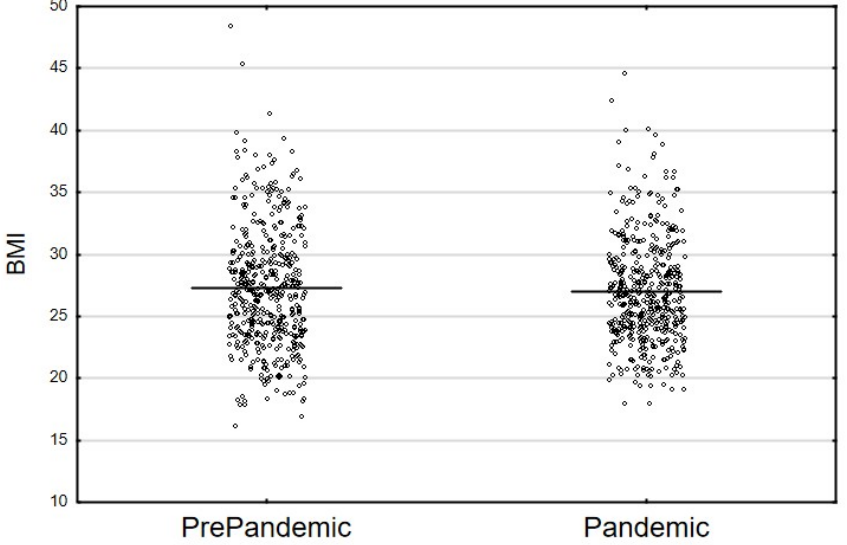
Figure 2. Distribution of the BMI variable in the PrePandemic vs. Pandemic samples (Student’s t -test: t (962) = 1.059; p = 0.290, horizontal lines illustrate the means).